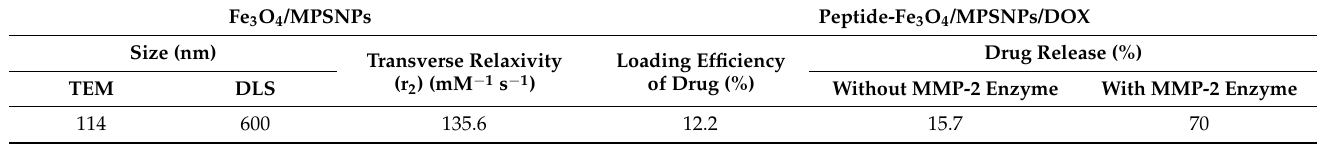
Table 3. The important characteristics of Fe 3 O 4 /MPSNPs in DOX delivery system and MRI. Fe 3 O 4 /MPSNPs Peptide-Fe 3 O 4